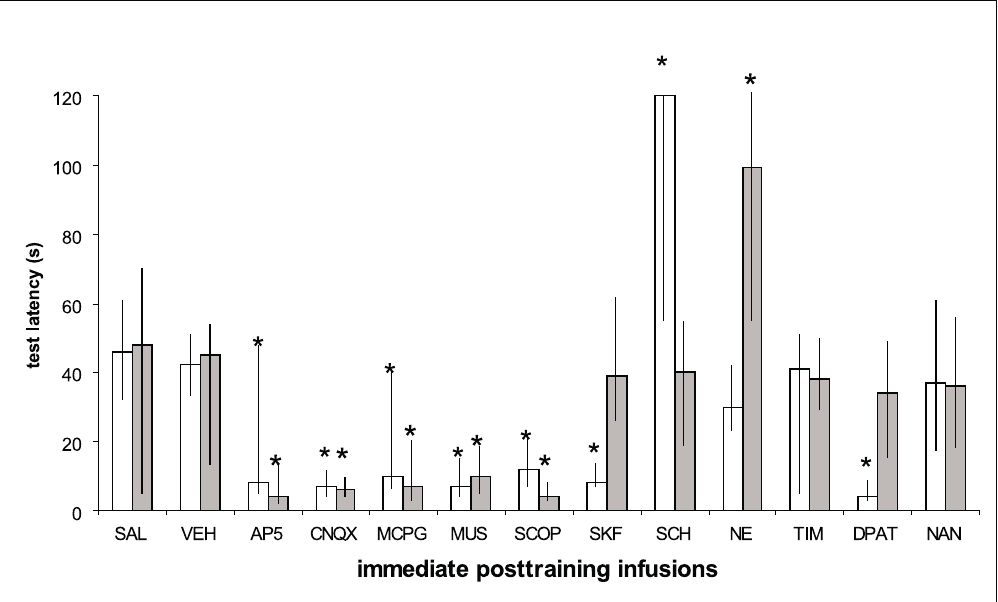
Fig. 1 – In this and all following figures, the ordinates express median (interquartile range) test session latency, in seconds. In this figure, memory of the step-down task was measured 1.5 h after training (STM) and again at 24 h (LTM), STM scores are shown in open columns and LTM scores are shown in grey columns. This figure includes data from five different papers (Izquierdo et al. 1998a, b, c, 1999, 2000). N = 10 − 12 per group. Infusion volume was 0 . 5 µ l in all cases. The following treatments were given by bilateral infusion into the CA1 area of the hippocampus: Saline (SAL), vehicle (VEH, 20% dimethylsulfoxide), AP5 (5 µ g/side), CNQX(0 . 5 µ g/side),MCPG(2 . 5 µ g/side),muscimol(MUS,0 . 5 µ g/side)andscopolamineHBr(SCOP,2 µ g/side), SKF38393 (SKF, 7 . 5 µ g/side), SCH23390 (SCH, 0 . 5 µ g/side), noradrenaline ClH (NE, 0 . 3 µ g/side), timolol ClH (TIM, 0 . 3 µ g/side), 8-HO-DPAT (DPAT, 2 . 5 µ g/side) and NAN-190 (NAN, 2 . 5 µ g/side). ∗ Indicates significant difference from control values at p < 0 . 001 level. In groups not marked by asterisks the training-test latency differences were significant at a p < 0 . 001 level. AP5, CNQX, MUS and SCOP caused amnesia both for STM and LTM. SKF and DPAT caused selective amnesia for STM, leaving LTM intact. SCH enhanced STM selectively and NE enhanced LTM